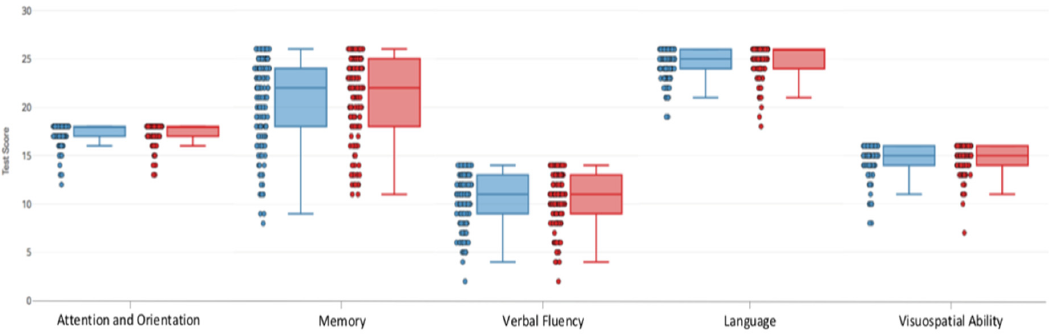
Figure A1. Box plots and distributions (values) of the ACE-R subcomponent scores at 1–3 months (blue) and 1 year (red).